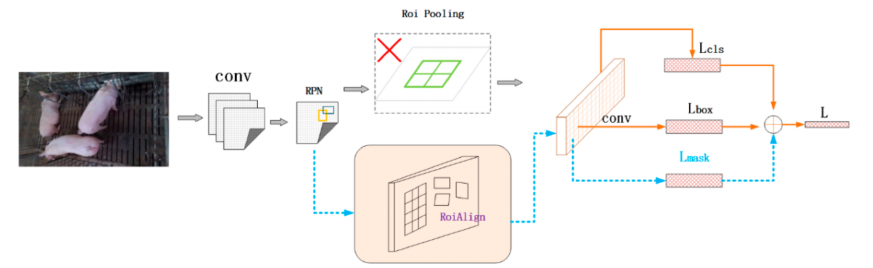
Figure 4. Mask-RCNN overall flow